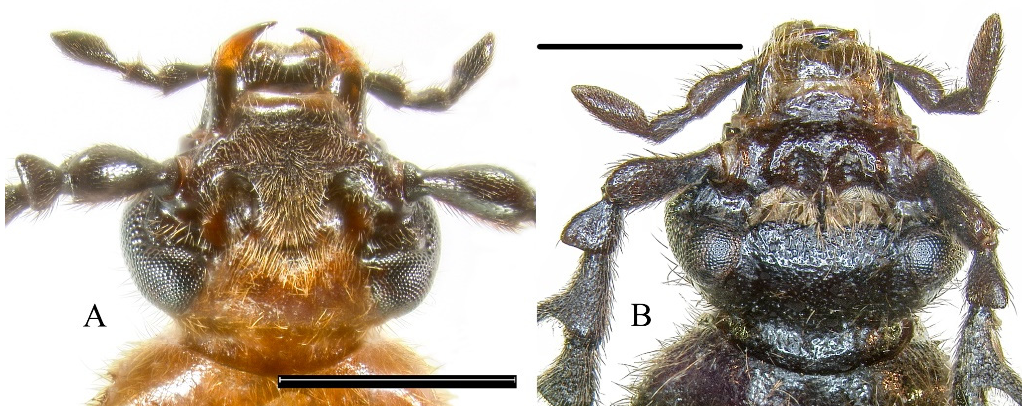
Figure 1. Head of Pseudopyrochroa spp., dorsal view. ( A ) P. punctifrons Young; ( B ) P. lateraria (Motschulsky). Scale bars: 1 mm.